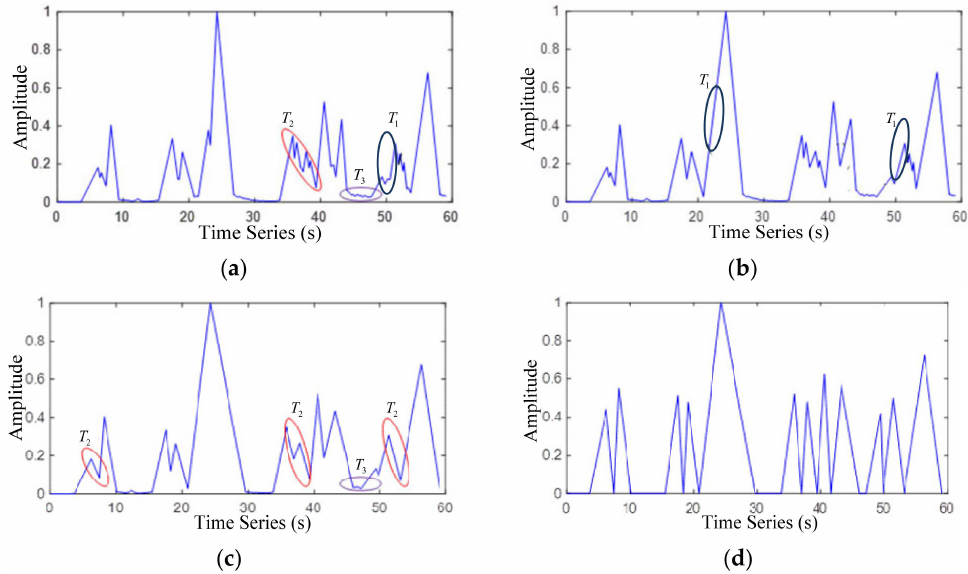
Figure 8. Formation and combination of triangular waves. ( a ) triangular wave formation, ( b ) combi- nation on triangular wave, ( c ) combination under triangular wave and ( d ) frame width